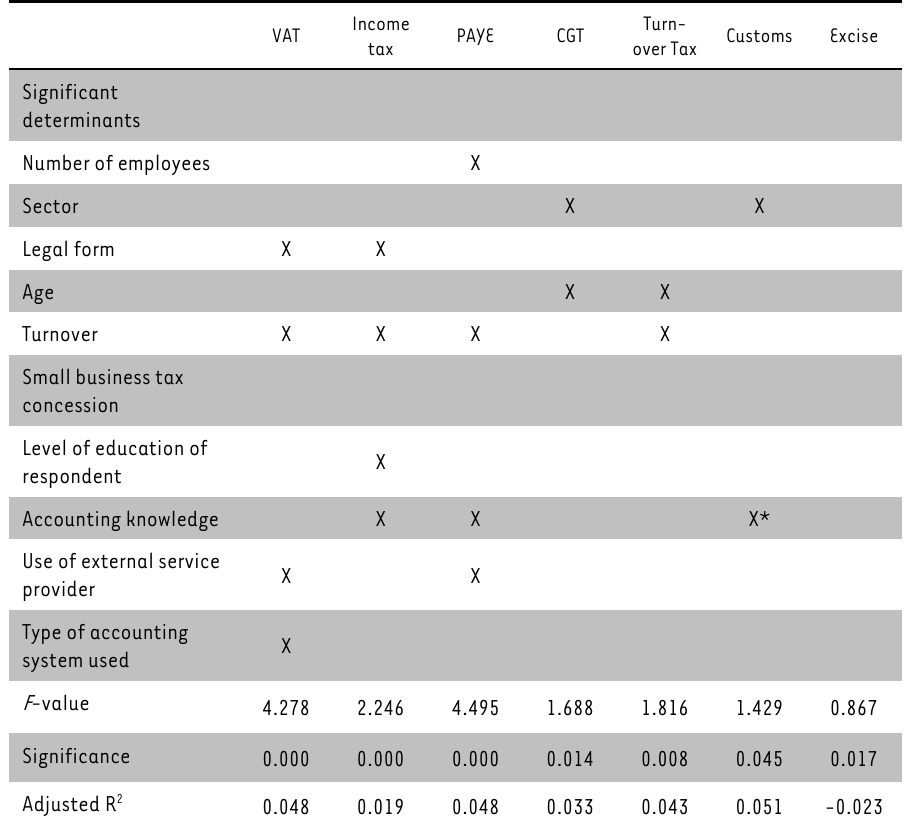
TABLE 1: Summary of significant determinants of internal tax compliance costs – Model